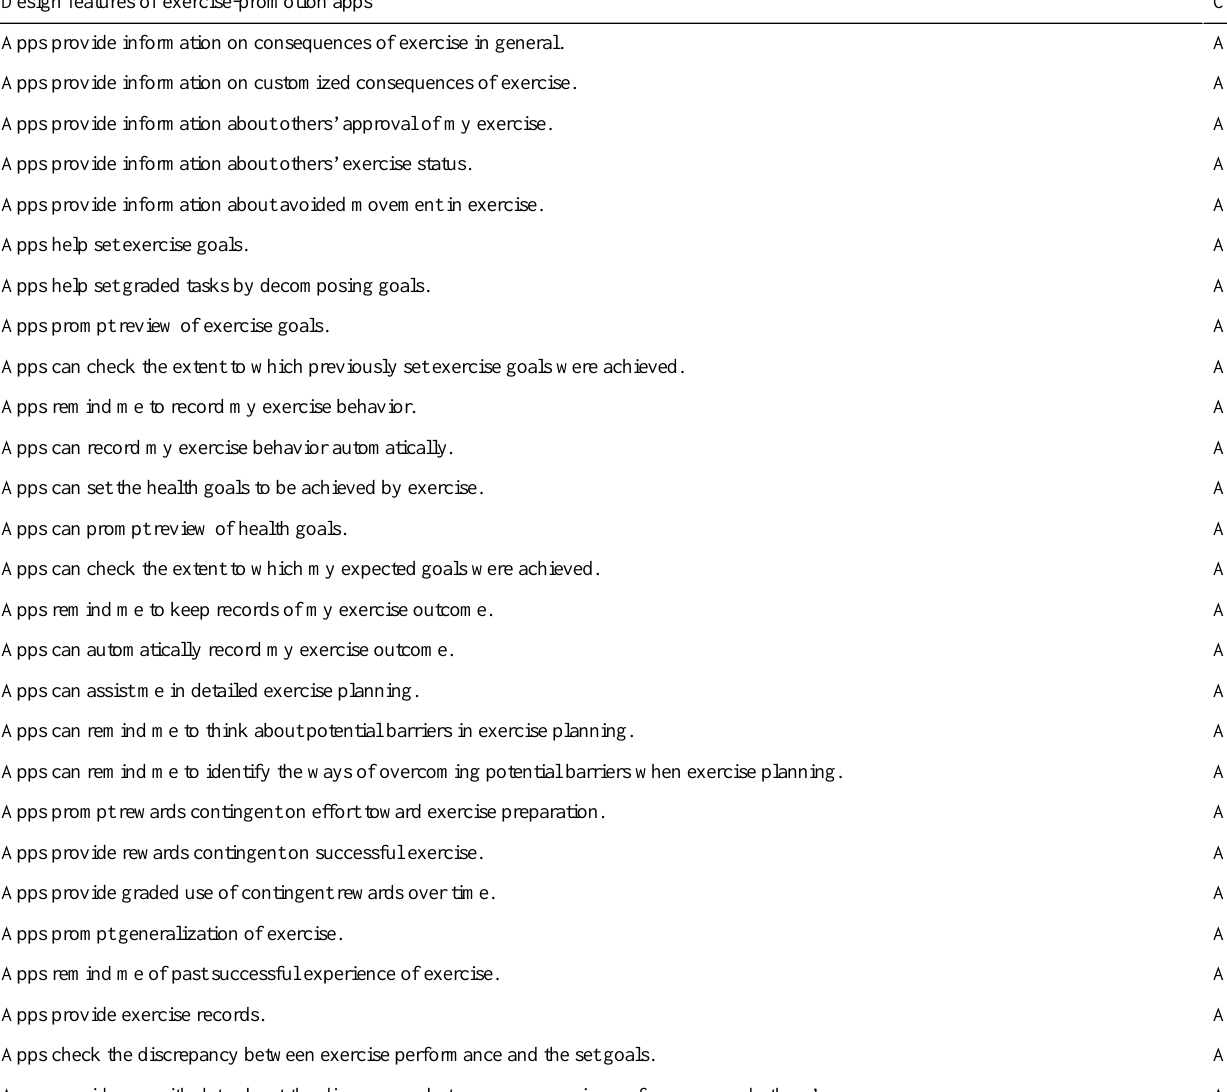
Table 2. A representative set of 52 design features based on the Coventry, Aberdeen, and London—Refined (CALO-RE) taxonomy. CodeDesign features of exercise-promotion